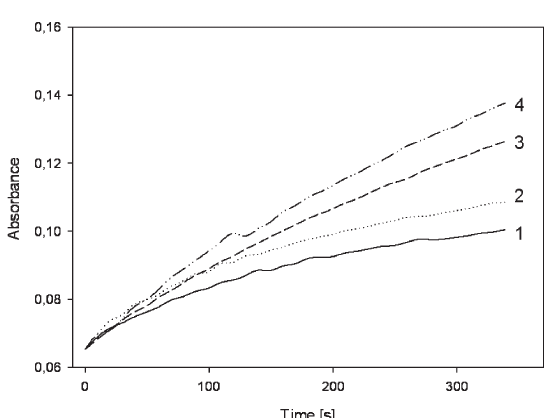
Figure 4. Effect of thermal treatment of G-quadruplex samples on the absorbance changes at 417 nm for ABTS reaction catalyzed by the Tel2/Brij 58 DNAzyme system: 1 – standard procedure with slow cooling, 2 – fast cooling before hemin addition, 3 – fast cooling after hemin addition.